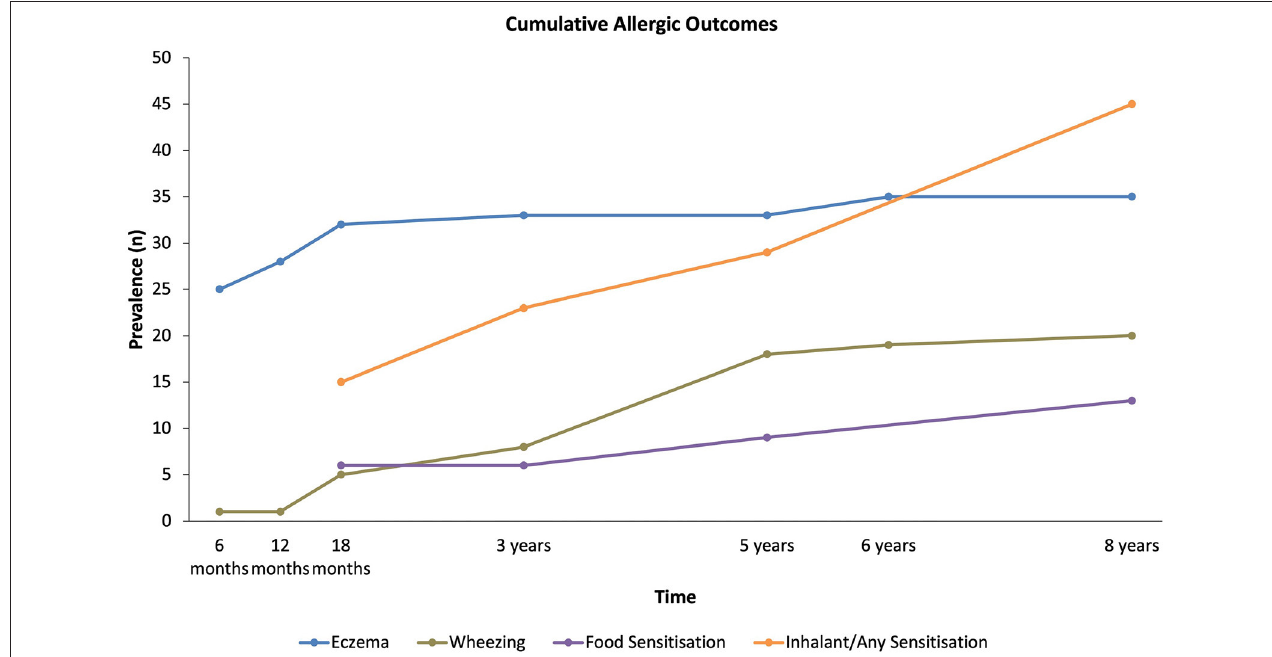
FIGURE 1 | Cumulative prevalence for all allergy-related outcomes up to 8 years of age. The trends for the increase in cumulative prevalence of each allergy-related outcomes over time were all significant ( p <